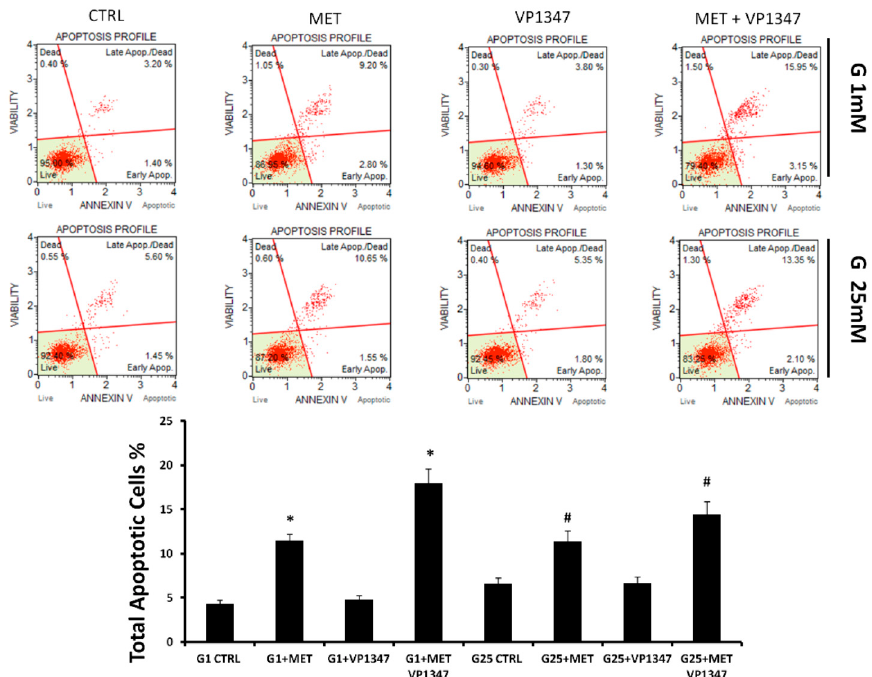
Figure 4. Effect of metformin and HO-1 activity inhibitor VP1347 on DU145 cells apoptosis. Cells were incubated with 1 mM glucose (G1) or 25 mM glucose (G25) in the presence and absence of 10 mM metformin (MET) and 10 µ M VP1347 for 12 h. Apoptosis was evaluated by cytometry, using the Muse Annexin V and Dead Cell Assay Kit. The graph showed the total apoptotic cells percentage in the different groups. * p < 0.05 vs. G1 CTRL, # p < 0.05 vs. G25 CTRL.